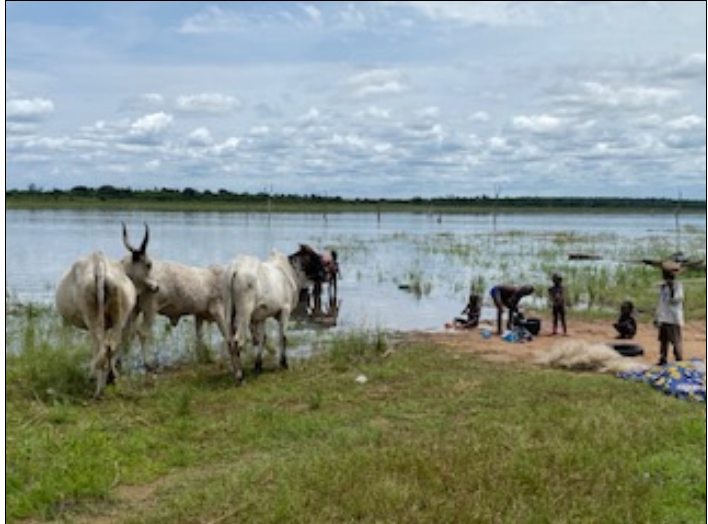
Figure 4. Humans and livestock animals interacting at a shared freshwater source near Abeokuta, the capital city of Ogun State, southwest Nigeria (The authors, 2022).